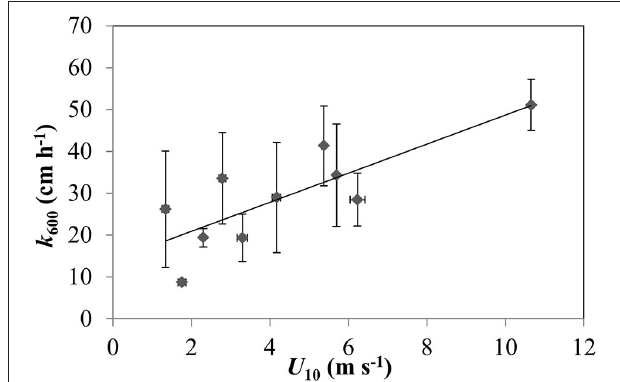
FIGURE 8 | Relationship between k 600 binned averages with wind speed ( U 10 ) bins of 0.5m s − 1 (Spearman, r = 0.7, p < 0.05).